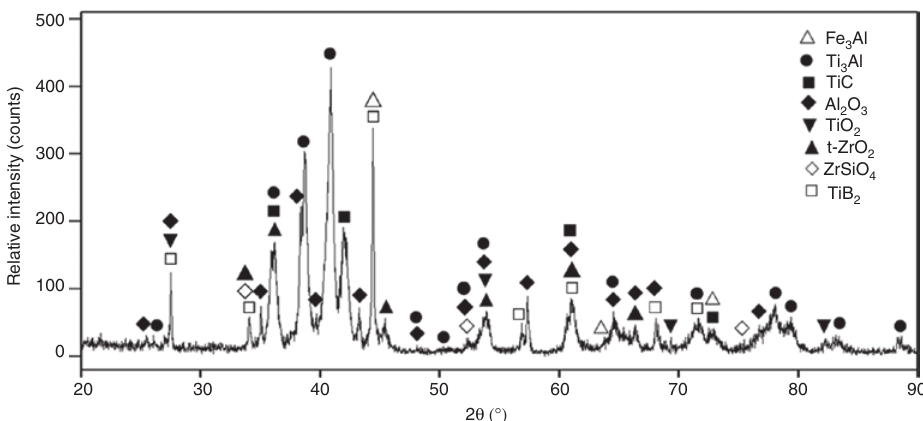
Al-B C-YPSZ-Al 3 4